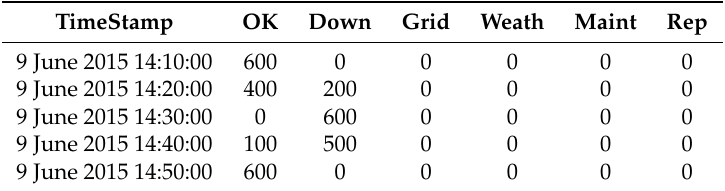
Table 3. Ten-minute availability